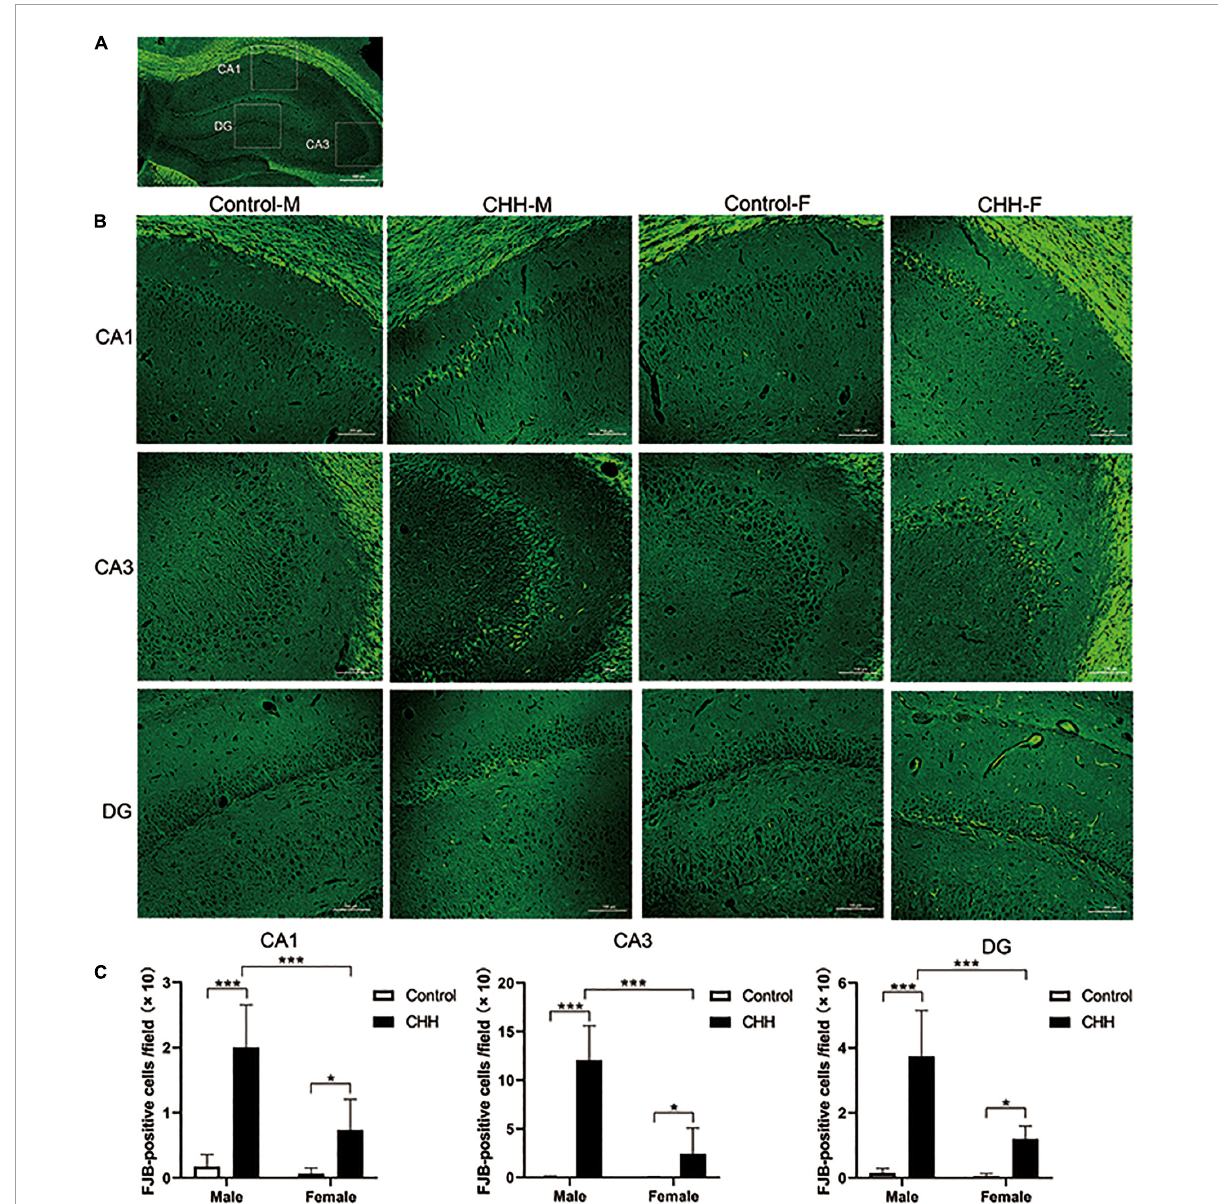
FIGURE5 The FJB staining in the hippocampus for degenerative neurons. (A) Representative scheme of the CA1, CA3, and DG subregions considered in the analysis. (B) Representative images viewed at 200 magnification for FJB staining, scale bar: 100 mm. (C) The statistical analysis of FJB positive cells in the hippocampal CA1, CA3, and DG regions is shown. Values are means ± SD for six animals/group. Data for male and female rats, with or without CHH exposure, were analyzed using two-way ANOVA. Post hoc analysis indicated: * p < 0.05, ** p < 0.01, *** p < 0.001.